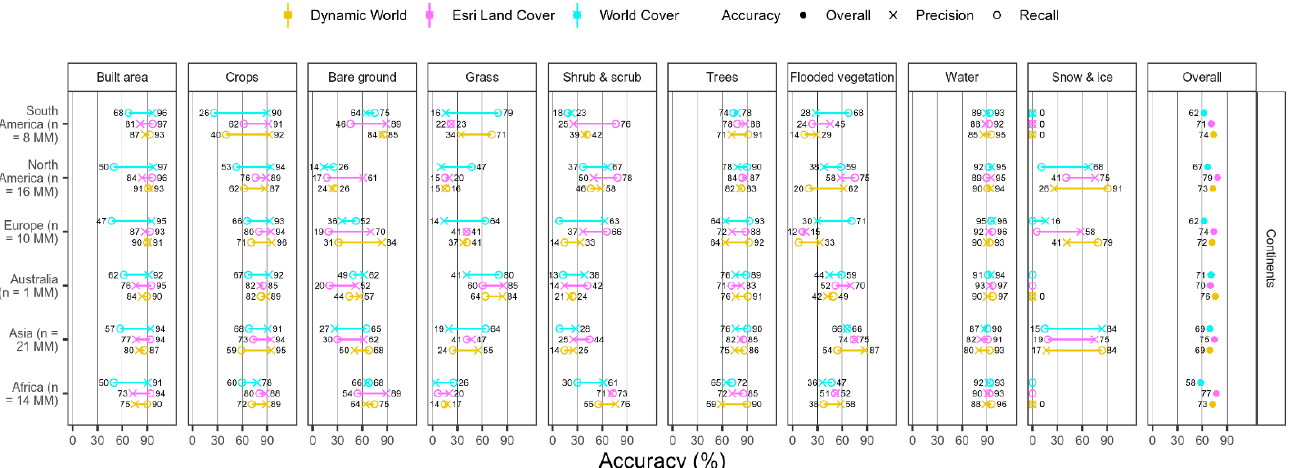
Figure 6. Accuracy of global 10 m land cover maps across LULC classes and continents based on